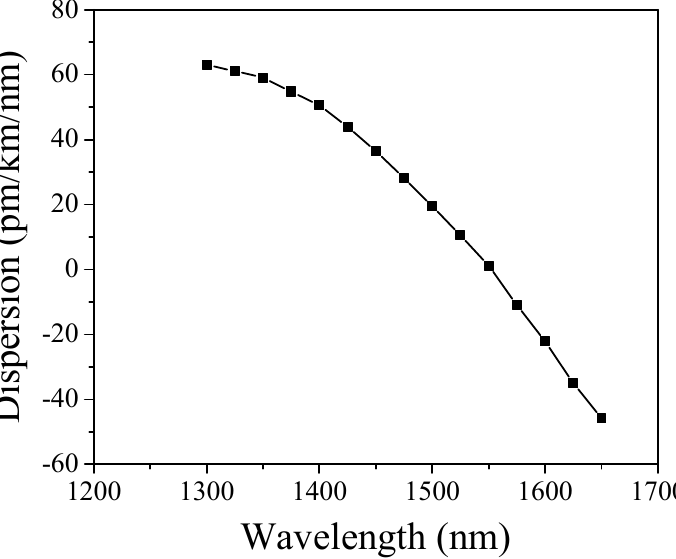
Figure 3. The dispersion as a function of wavelength of PECVD silicon nitride waveguide with optimized thickness of 710 nm and width of 1250 nm to get a near-zero dispersion around the wavelength of 1.55 µm.